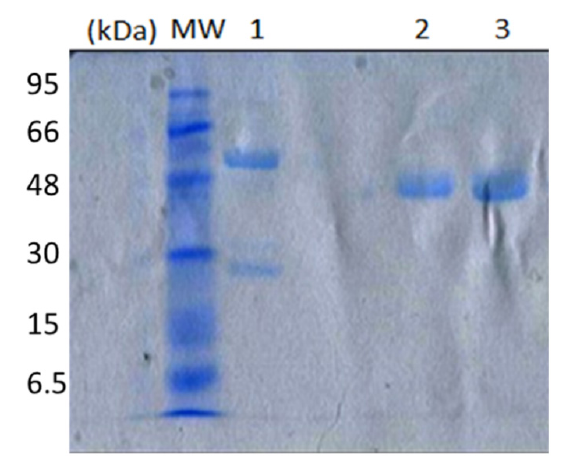
Figure 3. Analysis of purified IgG fractions on 12% SDS-PAGE under reducing conditions; lane 1, IgG1 with an apparent molecular weight of 50 kDa and 25 kDa. Lanes 2, 3 revealed a single band of 46 and 43 kDa corresponding to the heavy-chain antibodies (IgG2 and IgG3), respectively.